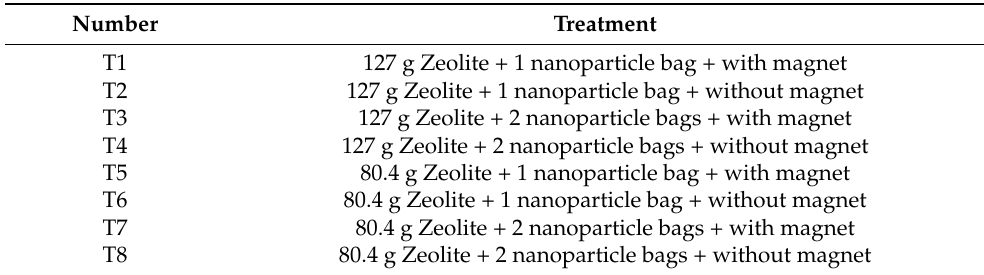
Table 1. Treatments evaluated with a 2 × 2 × 2 factorial